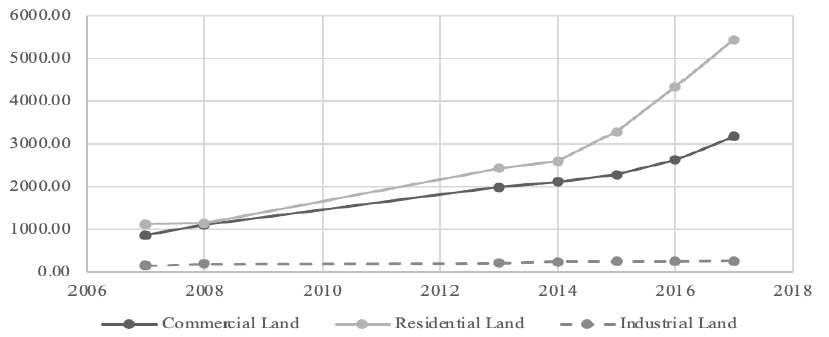
Figure 2. Land Sale Price Statistics by Type (2007–2017). Data Source : China Land and Resources Statistical Yearbook.